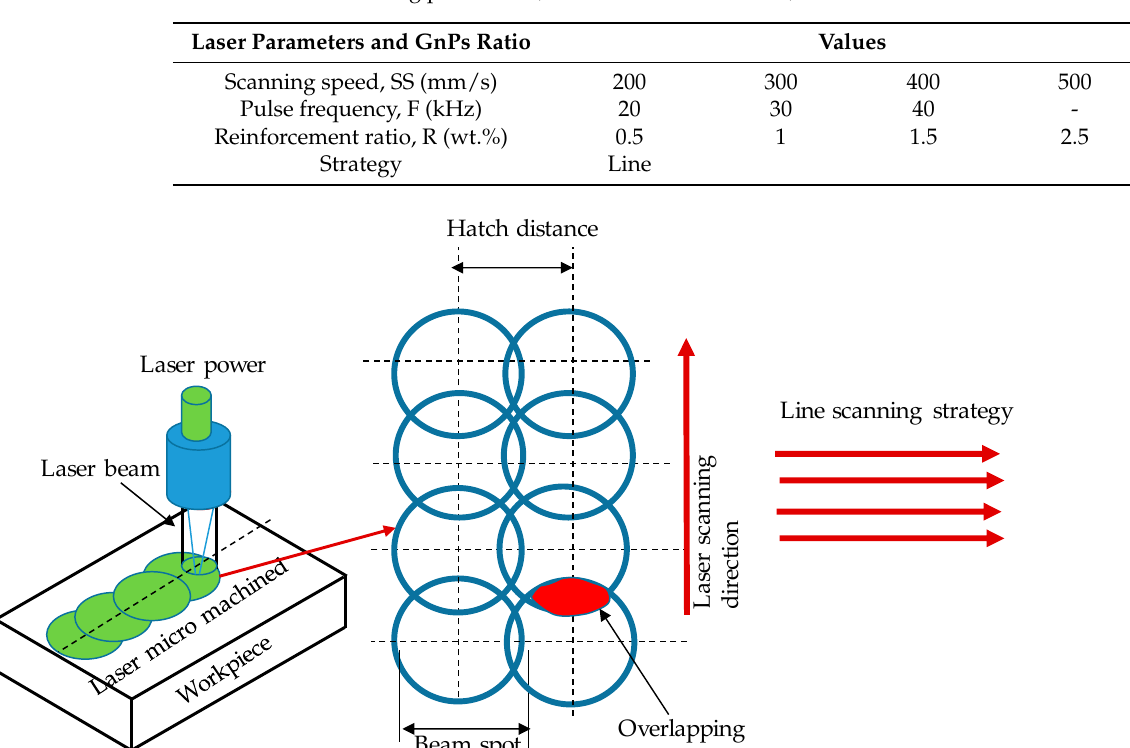
Table 3. Micromachining parameters, GnP reinforcement ratio, and their selected levels.